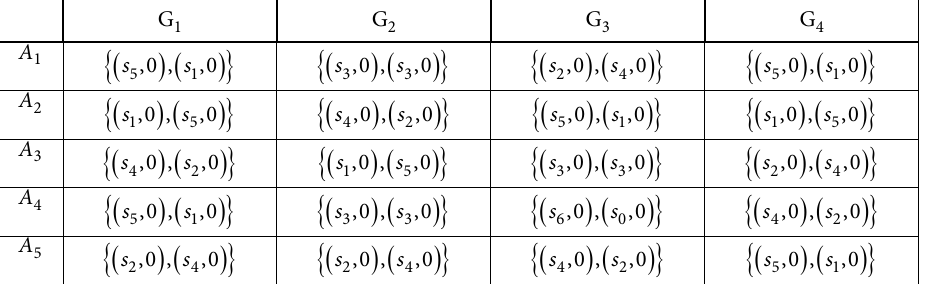
Table 7. The assessing matrix with 2TLPFNs by third expert